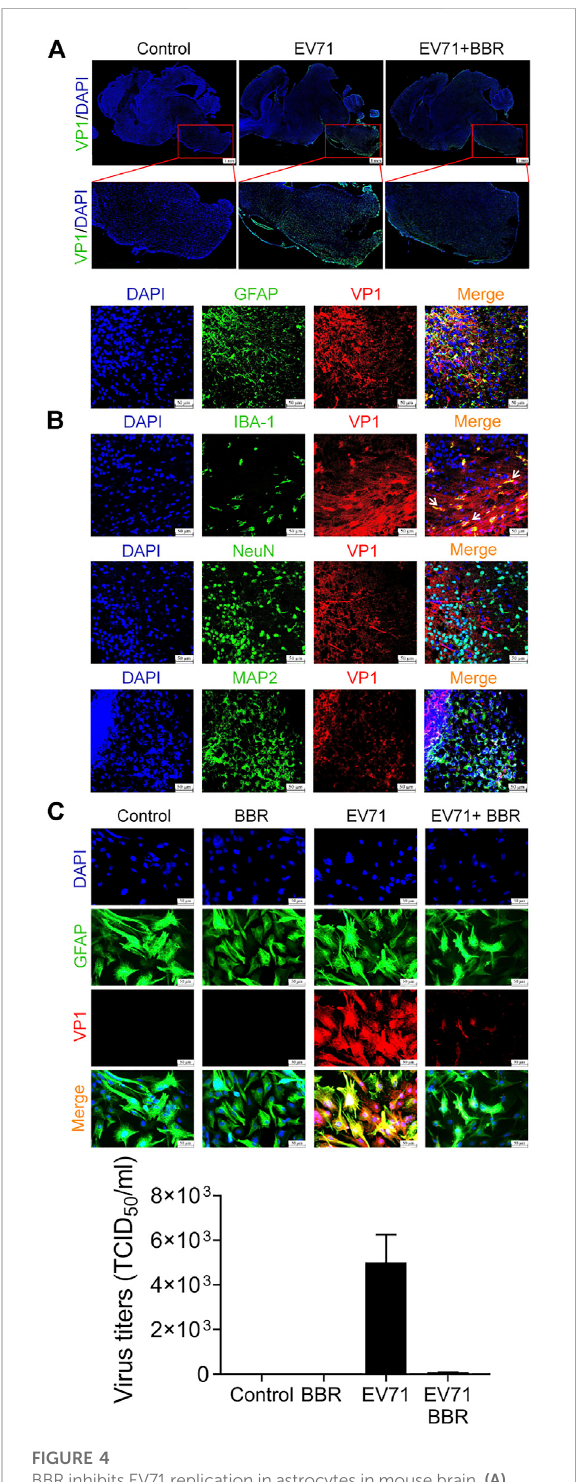
FIGURE 4 BBR inhibits EV71 replication in astrocytes in mouse brain. (A) Effects of BBR (5 mg/kg) on EV71 infection in the brainstem of newbornmice(48 – 72 hafterinfection).Longitudinalcryosections of brain containing brainstem were subjected to immuno fl uorescence staining with DAPI (Blue) and EV71 VP1 protein (Green). Bar = 1 mm. (B) Colocalization